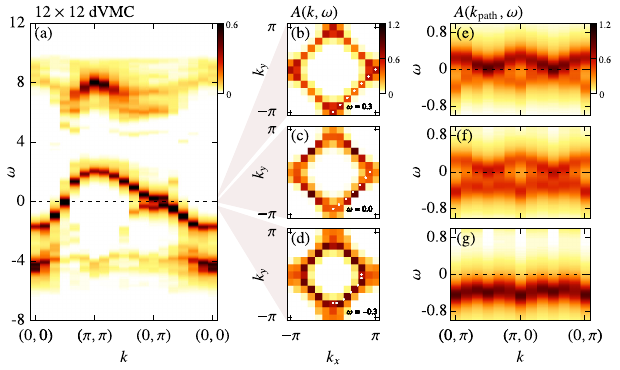
FIG. 7. Spectral function A ð k; ω Þ for a 12 × 12 cluster. (a) Same view as in Fig. 6(c). (b) – (d) Spectral function for a constant energy at and around the Fermi level ( ω ¼ 0 . 0 ) plotted in the Brillouin zone. Energies are, respectively, ω ¼ 0 . 3 , 0.0, and − 0 . 3 . (e) – (g) Spectral function in the momentum-energy plane, with the momentum following the symmetric line along ð 0 ; π Þ − ð π ; 0 Þ − ð 0 ; π Þ . The labels of the k axis on the abscissa in these panels show only the points on the trajectory of white dots closest to the symmetric points because the white-dot trajectory is not precisely along the symmetric line. We follow the maximum intensity lines in the Brillouin zone of the corresponding panel on the left. The choice of k points in the path in panel (e) is shown with the white dots in the correspond- ing panel on the left [panel (b)]. The same is true for panels (c) and (f) and for panels (d) and (g), but in these cases, we use linear interpolations to more precisely identify the paths away from the discrete k points. The superconducting d -wave gap structure is clearly seen in panel (f). Note that in this figure, panel (a) has the same color scale as the rest of the paper, but panels (b) – (g) have another color scale (shown in the top right), in order to see more clearly the details in the superconducting gap and around the Fermi